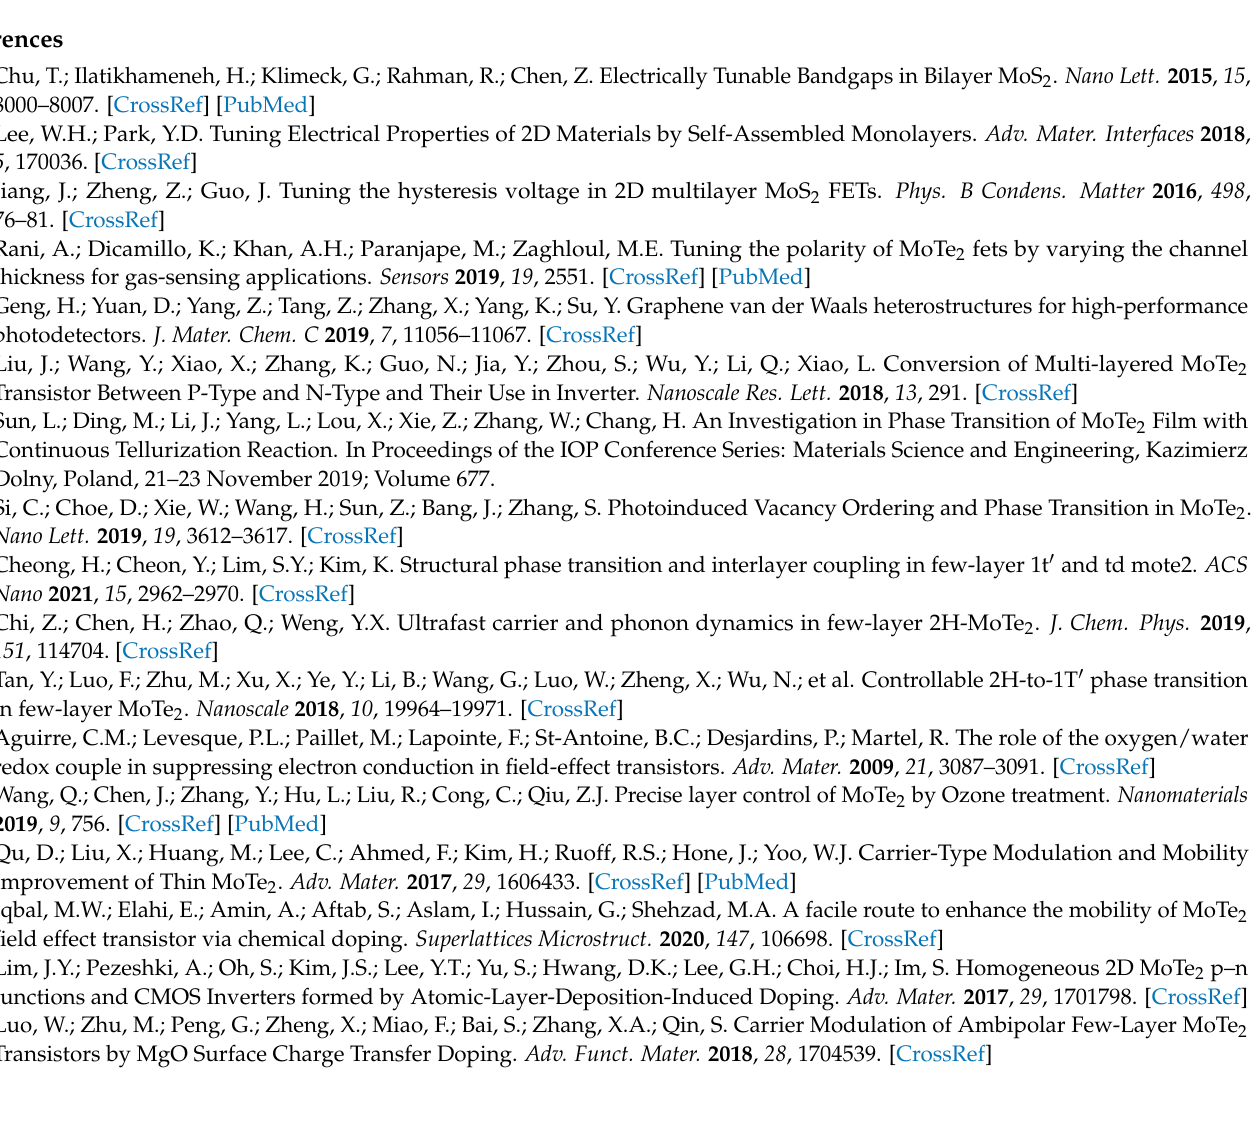
10.3390/app12083840/s1, Figure S1: Transfer curves of MoTe 2 Device #1, Figure S2: Transfer curves of MoTe 2 Device #2, Figure S3: Transfer curves of MoTe 2 Device #3, Figure S4: Transfer curves of MoTe 2 Device #4, Figure S5: Output curves (Ids − Vds) of Device #1 under zero gate bias, Figure S6: Raman spectra of air-heated MoTe 2 Device #2, Figure S7: Raman spectra of toluene treated, air-exposed MoTe 2 flake, Figure S8: Transfer Characteristics curves of as-fabricated (dark grey) and air-exposed for 1-month (blue) MoTe 2 FET, Figure S9: Transfer Characteristics curves of MoTe 2 FET air heated at 150 ◦ C, Figure S10: Raman Spectra of air heated MoTe 2 flake over a range 150–110 cm − 1 (inset: optic image), Figure S11: (a) Transfer curves and (b) AFM height profile (inset: AFM image) of MoTe 2 FET